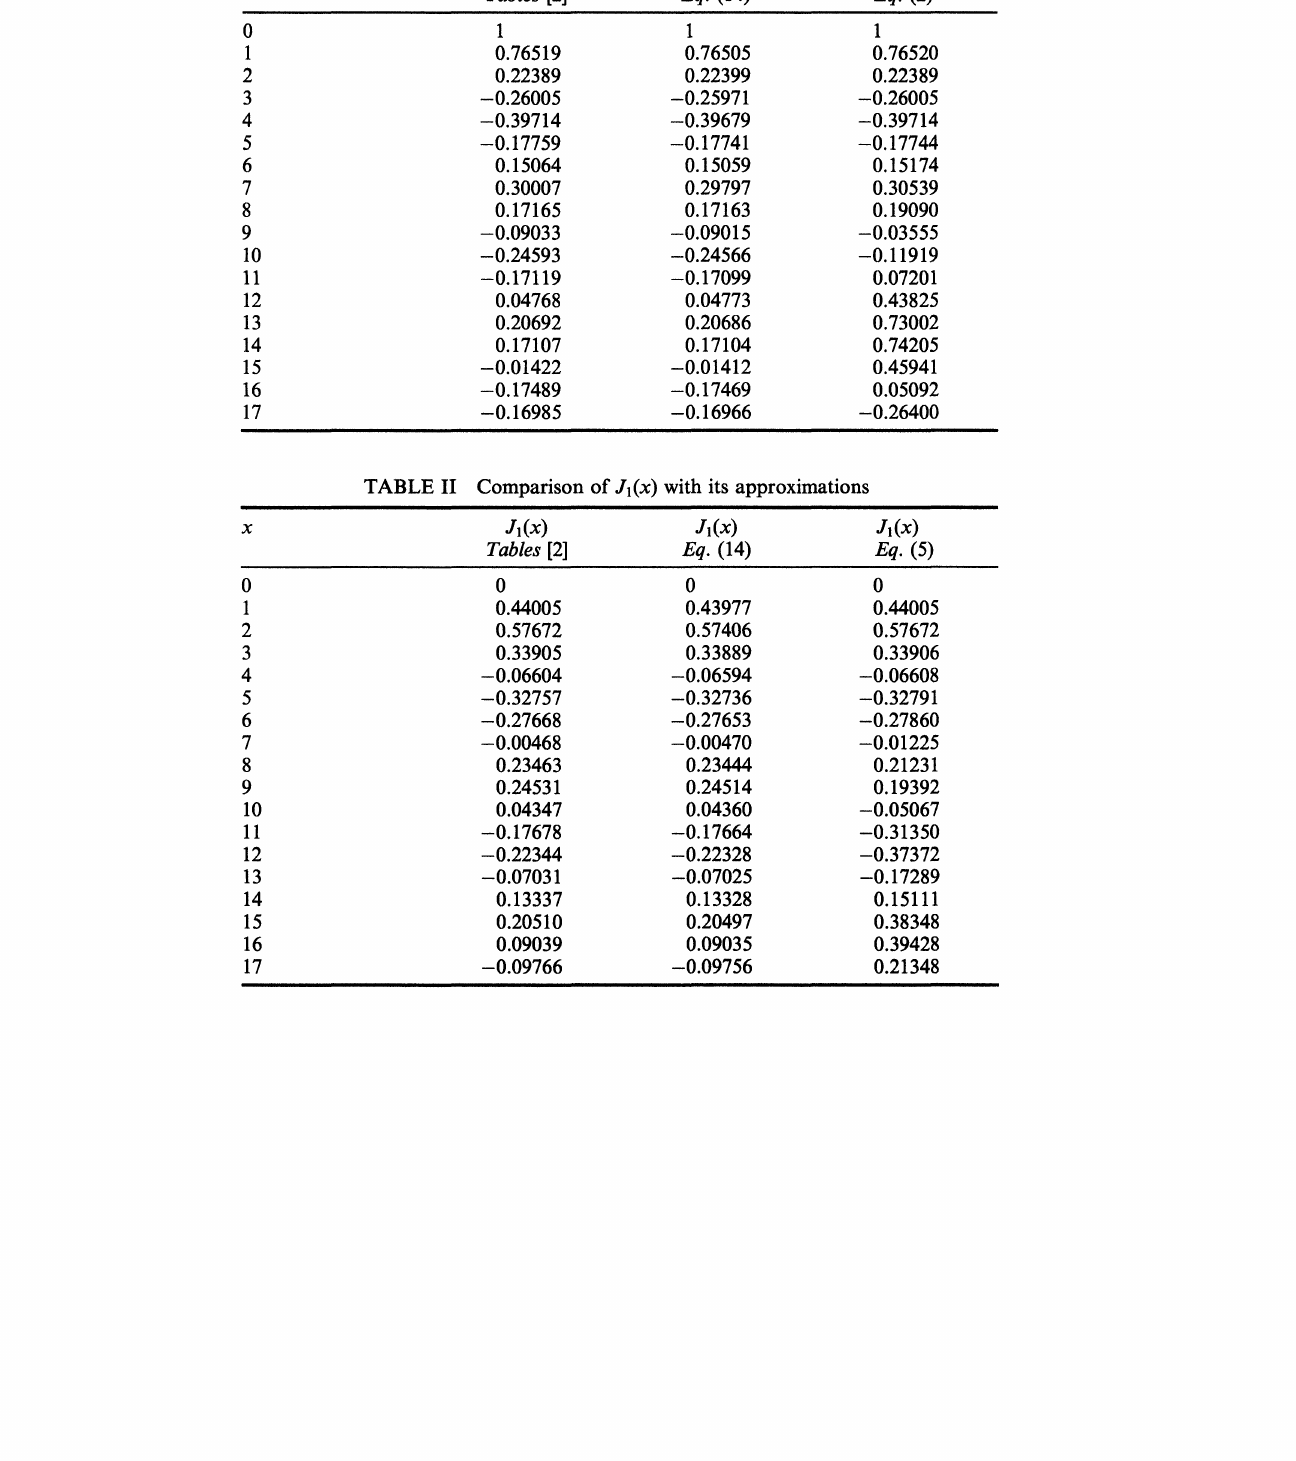
Comparison of Jo(x) with its